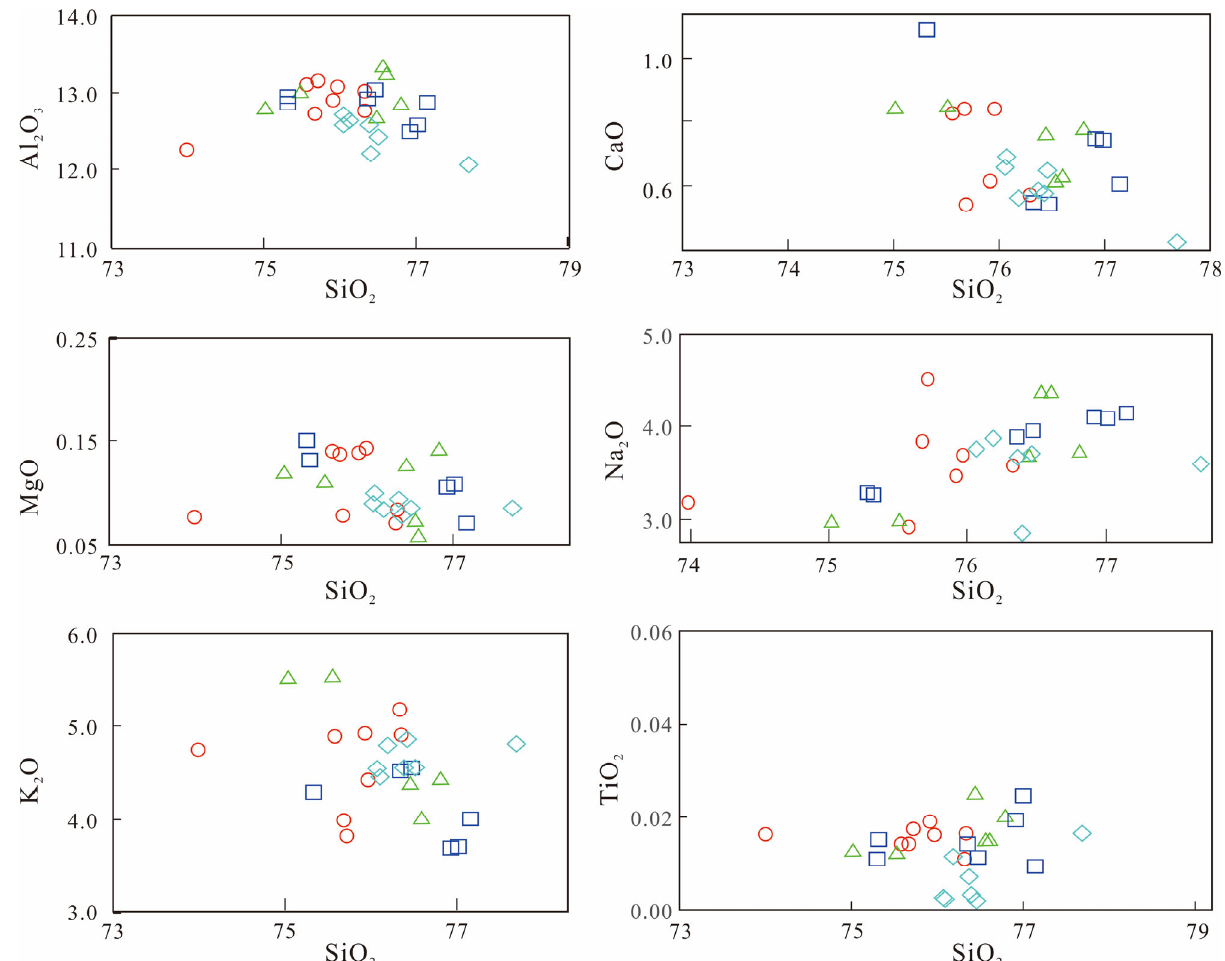
Minerals 2023 , 13 , x FOR PEER REVIEW Figure 5. Harker diagrams for the Helong granites. Symbols as in Figure 4. Figure 5. Harker diagrams for the Helong granites. Symbols as in Figure 4.